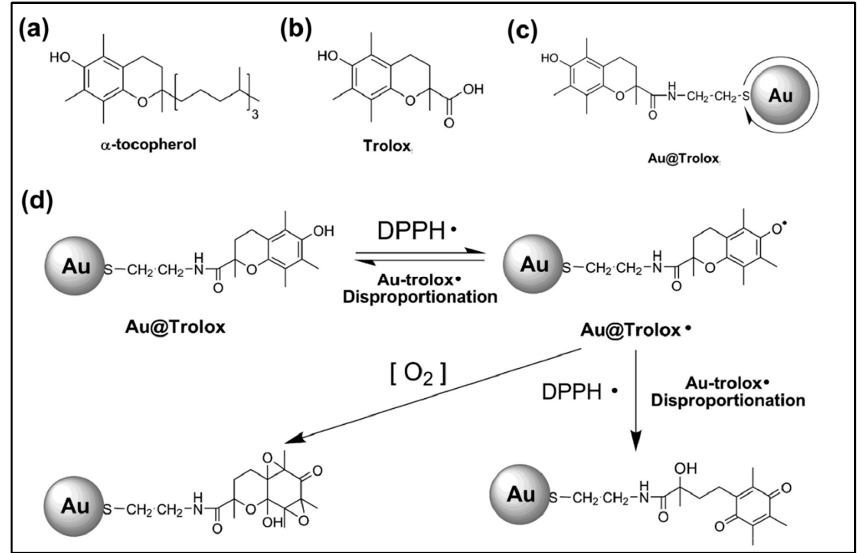
Figure 3. Molecular structure of ( a ) alpha-tocopherol, ( b ) Trolox, ( c ) Trolox functionalized AuNPs, and